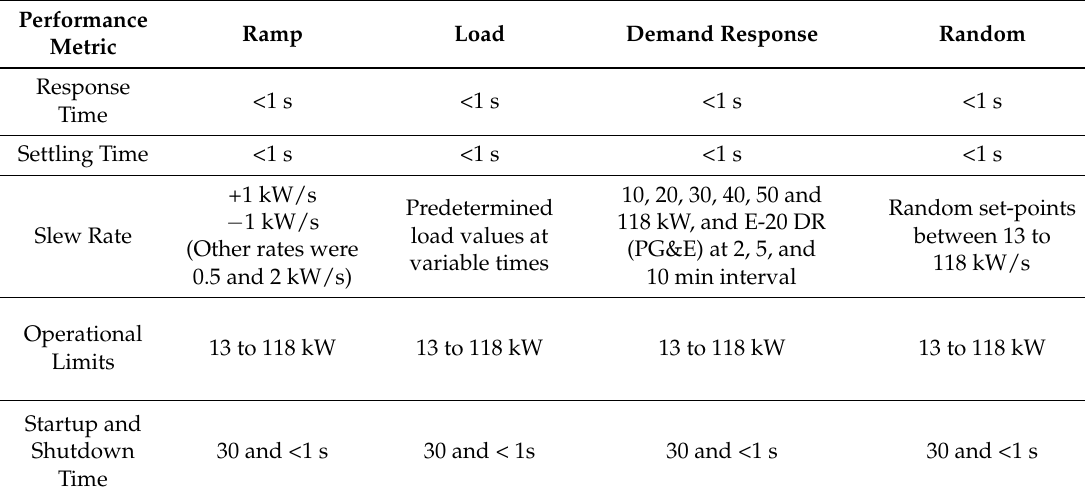
Table 1. Load characterizations of the 120 kW electrolyzer stack for different loading